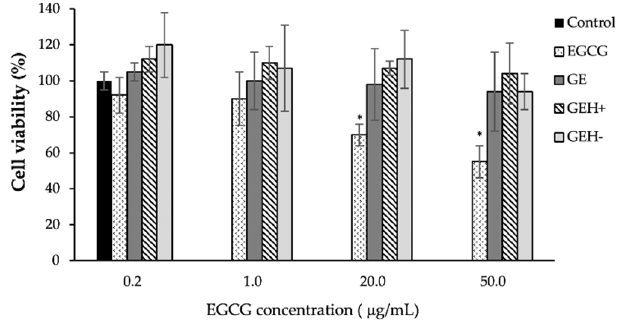
Figure 3. Cell viability of ARPE-19 cultured with variant NPs formulation in different EGCG concentrations for one day (mean ± SD, n = 6), * p < 0.05 compared with control.